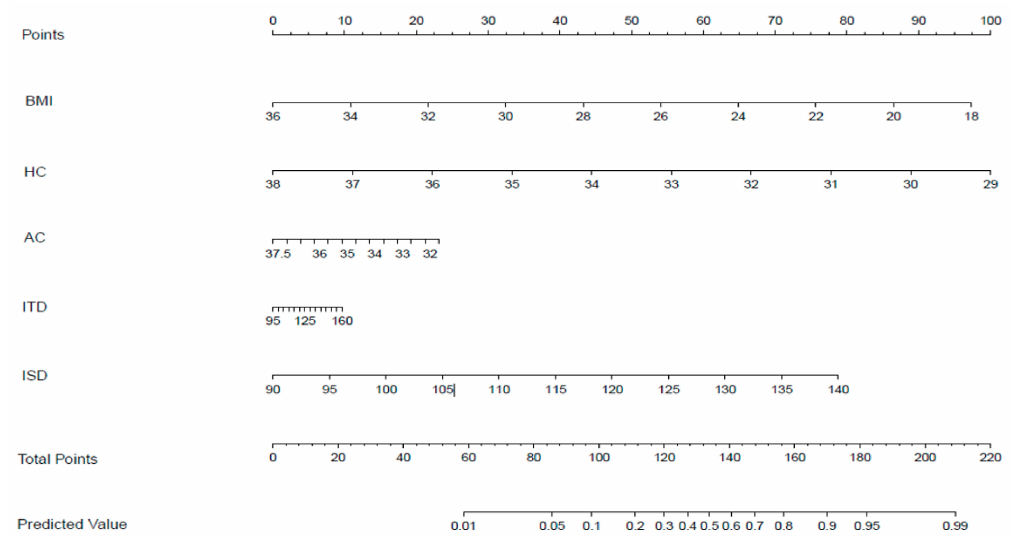
Figure 3. A predictive nomogram for the probability of vaginal delivery. The nomogram is used as follows: (1) to obtain the nomogram-predicted probability, locate values on each axis; (2) draw a vertical line to the point axis to determine how many points are attributed for each variable value; (3) sum the points for all variables; (4) locate the sum on the total point line to assess the vaginal delivery probability at the lower line of the nomogram.